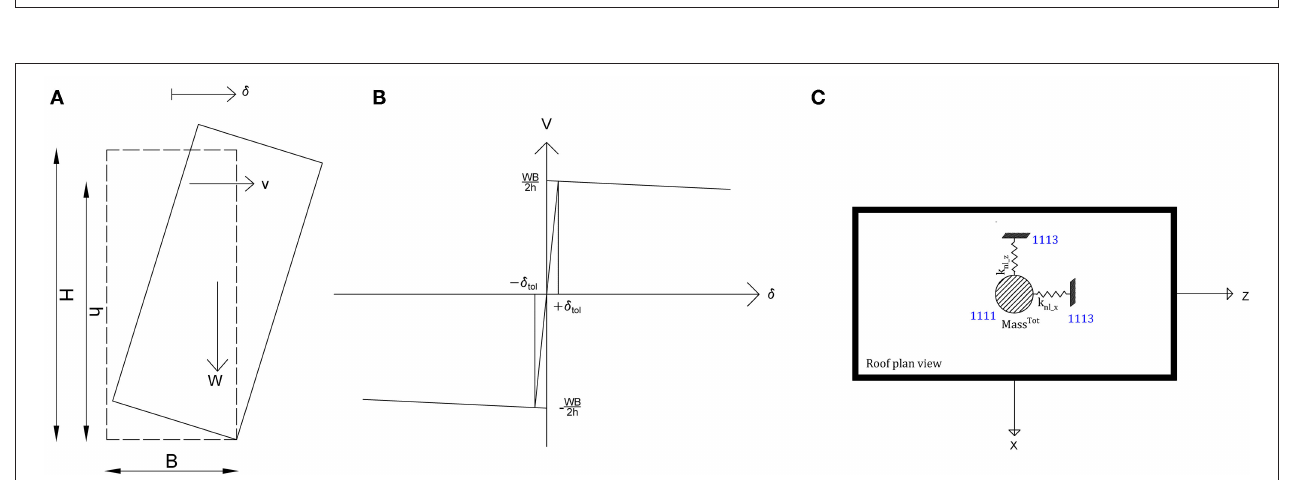
FIGURE 5 | Rocking panel: (A) geometry and loads, (B) non-linear force–displacement relationship, and (C) schematic view of the numerical model assumptions for the Rocking arrangement.